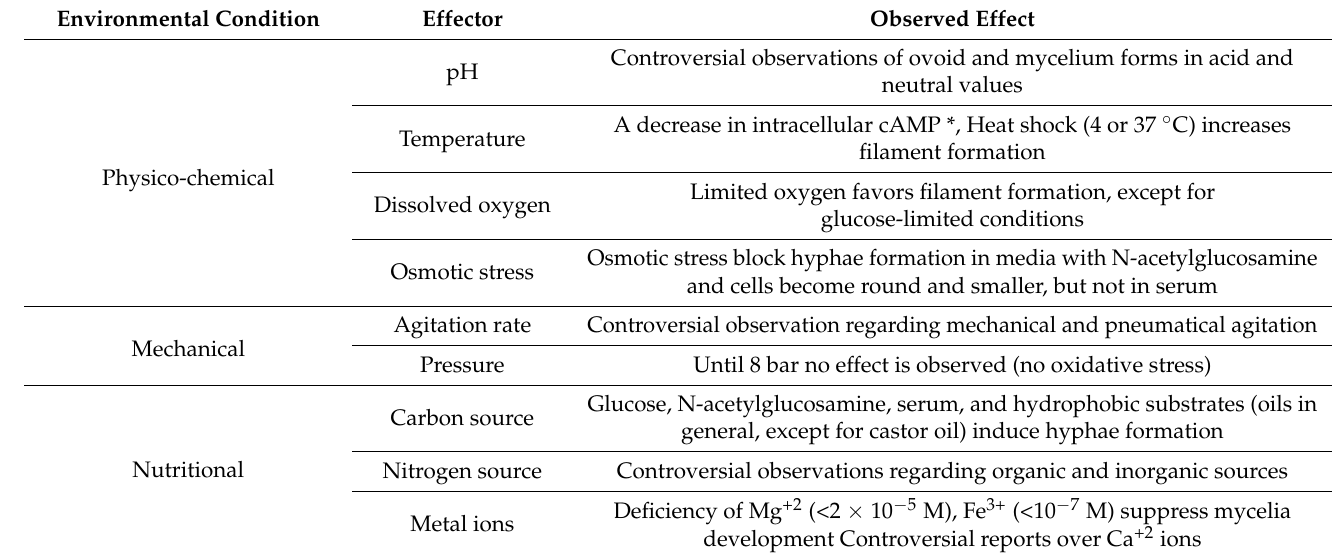
Table 1. Morphology responses of Y. lipolytica to different environmental